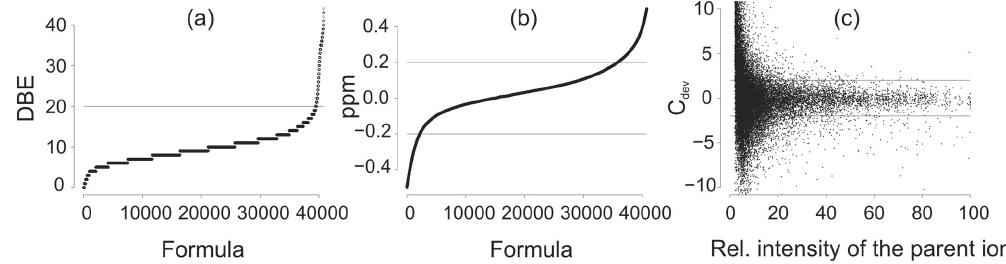
Figure 2. Validation of molecular formulas: (a) double bond equivalent (DBE) and (b) mass accuracy (in ppm) are displayed in increasing order for molecular formulas assigned in the complete data set. The quality of the peak magnitude ratio of a 12 C-parent formula versus the corresponding 13 C daughter formula ( 13 C 12 C n − 1 ) was calculated as (c) the difference between the number of carbon atoms in the assigned 1 formula and the number of carbon atoms estimated from the stable carbon isotope ratio (C dev , Koch et al., 2007). C dev is displayed versus the relative intensity of the parent ion.